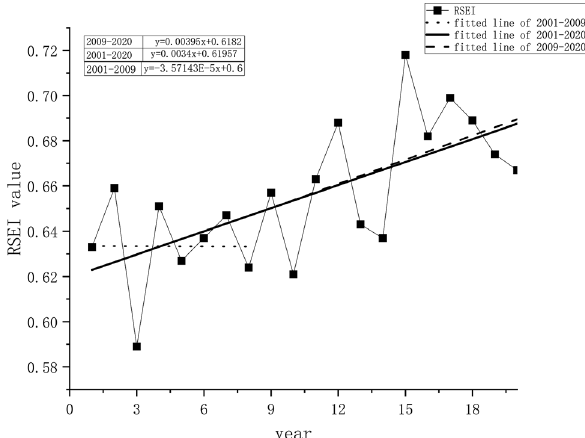
Figure 2. The interannual trend of the mean value of the